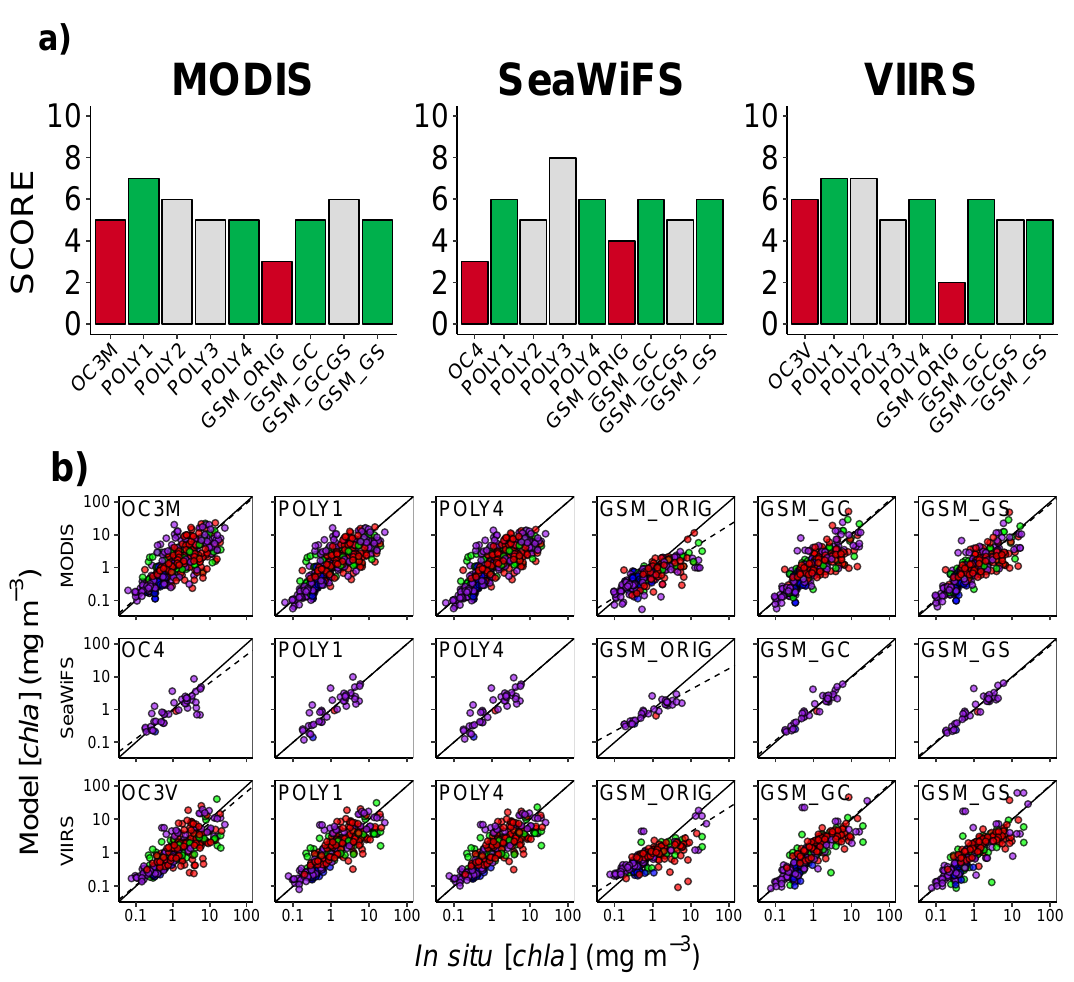
Figure 5. Same as Figure 4, for the NEP. Note the colour-coding for the solid circles in ( b ): blue corresponds to winter, green to spring, purple to summer, and red to